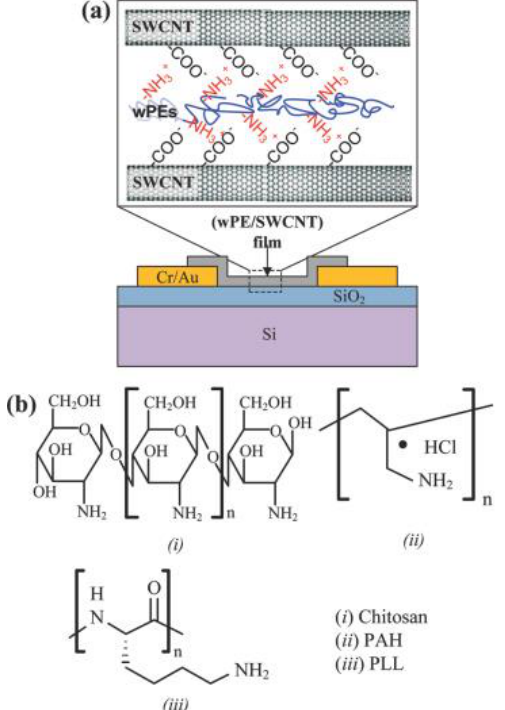
Figure 4. Layer-by-layer-assembled carbon nanotube thin-film device. ( a ) schematic of device and ( b ) molecular structure of the polyelectrolytes. Reprinted with permission from [68]. Copyright (2011) American Chemical Society.